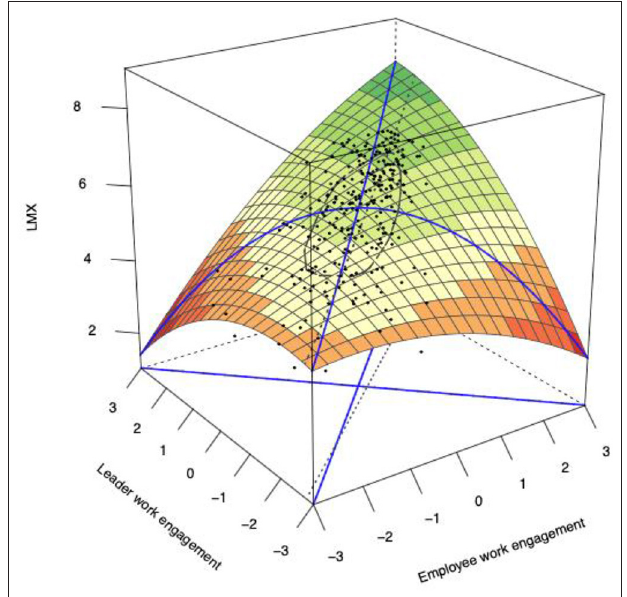
FIGURE 2 | Congruence (incongruence) effects of follower-leader work engagement on LMX.